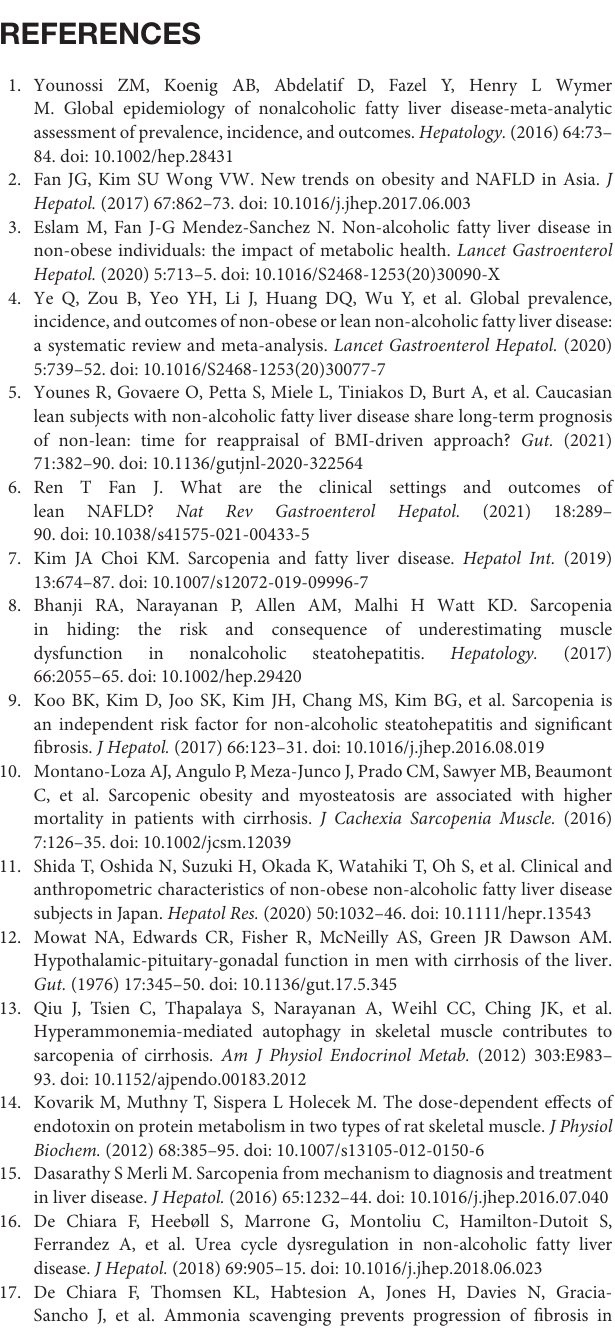
inflammation score, and (C) ballooning score based on the NAS scoring system are evaluated ( n = 6). The expression levels of (D) lipid metabolism-related genes (SREBP1c, FAS, SCD1, PPAR α , and CPT1A), (E) inflammation-related genes (TNF α , IL6, CCL2, CCR2), and (F) fibrosis-related genes ( α SMA, TGF β , Col1 α 1, Col1 α 2) are determined by real-time PCR. Relative expression levels were normalized to those of actin. The data are presented as the mean ± SEM, unpaired two-tailed Student’s t -test. ∗ P < 0.05, vs. mice fed with chow diet; # P < 0.05, vs. mice fed with